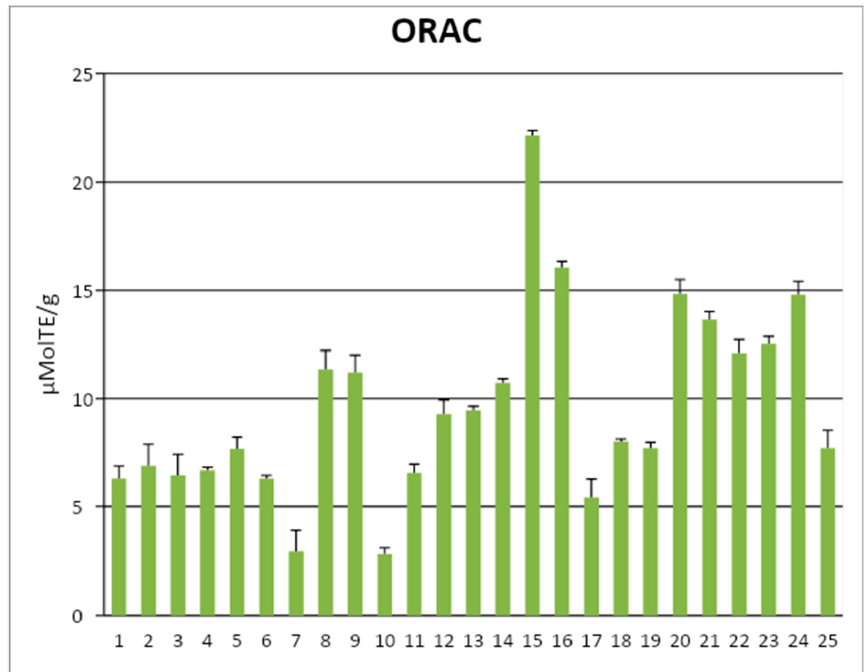
Figure 3. Heterogeneity of EVOO antioxidant capacity measured with the ORAC method on 25 oil samples. Values allow us to distinguish four categories of antioxidant capacity, putatively assigned by us in the following ranges: 1–4, low quality; 4–8, intermediate; 8–12, high; >12, top quality. Adapted from Antonini et al.